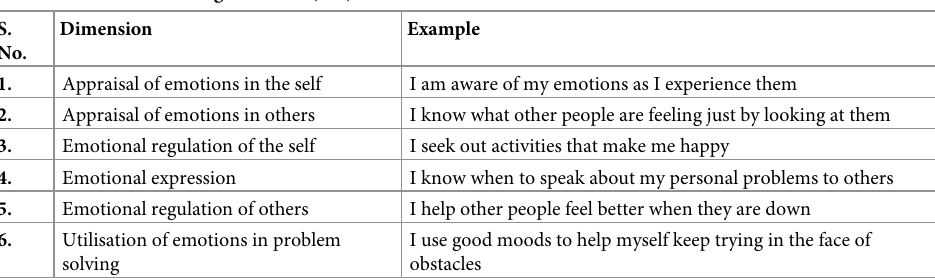
Table 2. Emotional Intelligence Scale (EIS).